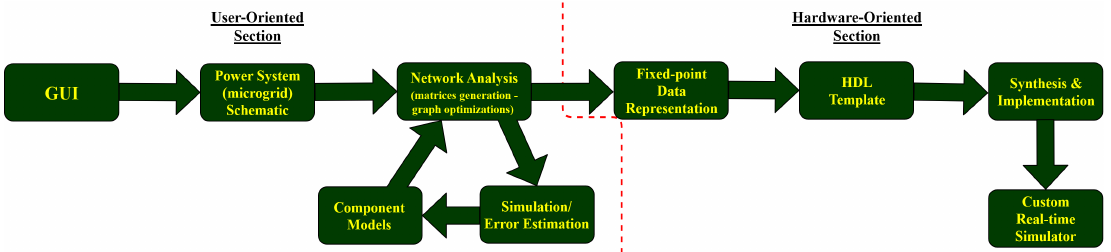
Figure 2. Logic diagram of the proposed